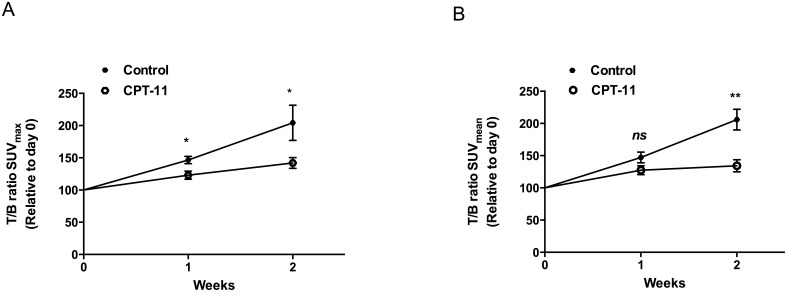

18F-FET uptake in xenografts.A) The relative T/B ratio of SUVmax versus time after tumor engraftment. B) The relative T/B ratio of SUVmean versus time after tumor engraftment. Values expressed as mean ± SEM in the CPT-11 (n = 5–7) and in the control group (n = 4–7), *p<0.05 and **p<0.01.